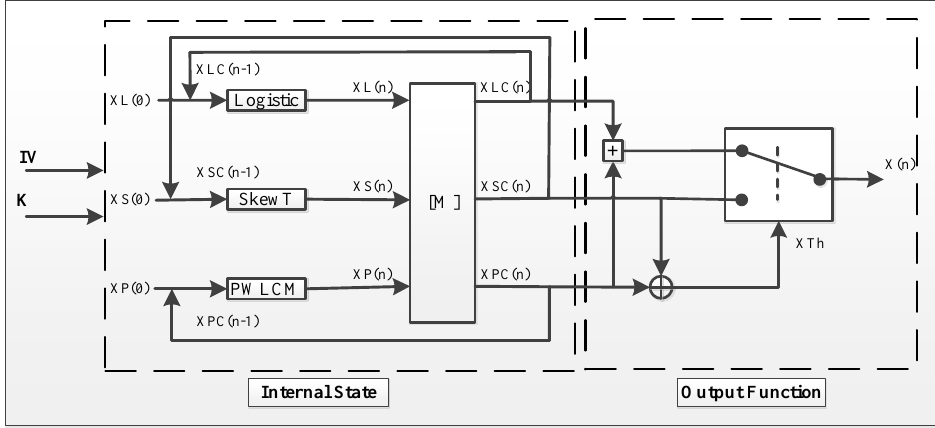
Figure 6. LSP-PRNG design architecture proposed. The proposed LSP-PRNG takes a secret key K and an initialization vector IV as input and computes initial values XL ( 0 ) , XS ( 0 ) and XP ( 0 ) of the three chaotic maps: Logistic, Skew-Tent, and PWLCM respectively. The IV of the system supplies the initial vectors of the three chaotic maps: IVL , IVS , and IVP each are of size N = 32 bits, and the secret key K provides all the initial conditions and parameters of the chaotic maps and the parameters of the coupling matrix M, as summarized in Table